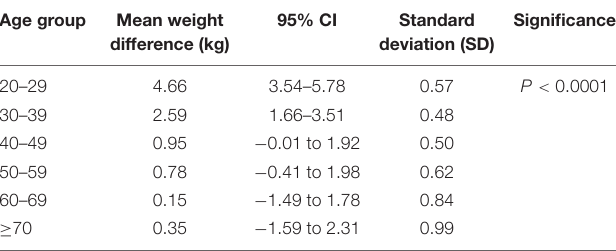
TABLE 3 | Changes in the Participants’ body